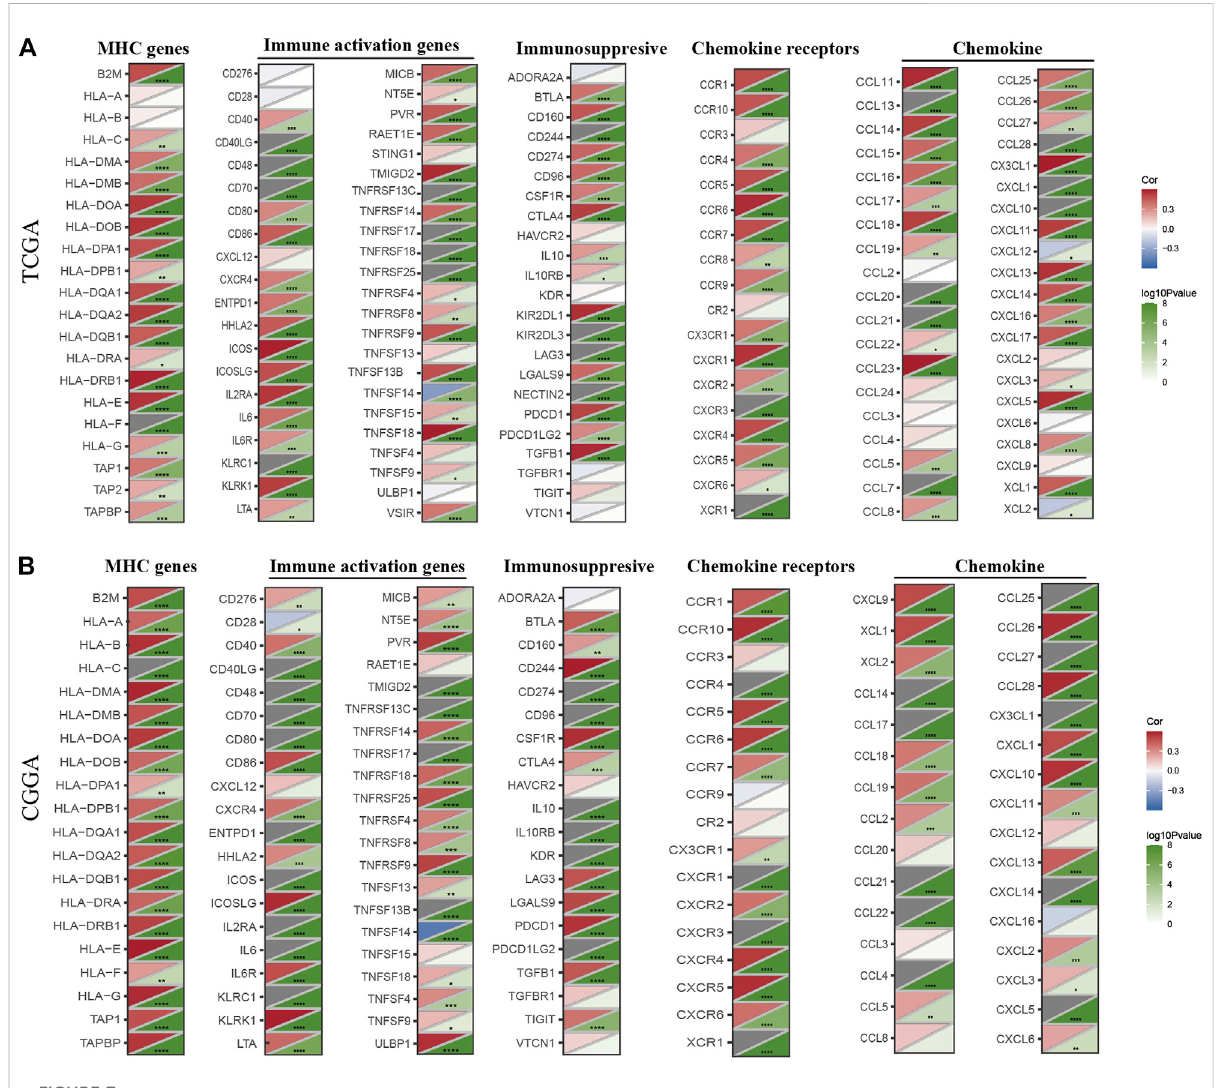
FIGURE 7 Co-expression of HK3 with immune-associated genes. Co-expression between HK3 and MHC genes, immune-activated genes, immunosuppressive genes, chemokines, and chemokines receptors in the TCGA (A) and CGGA (B) cohorts. (* p < .05, ** p < .01, *** p <